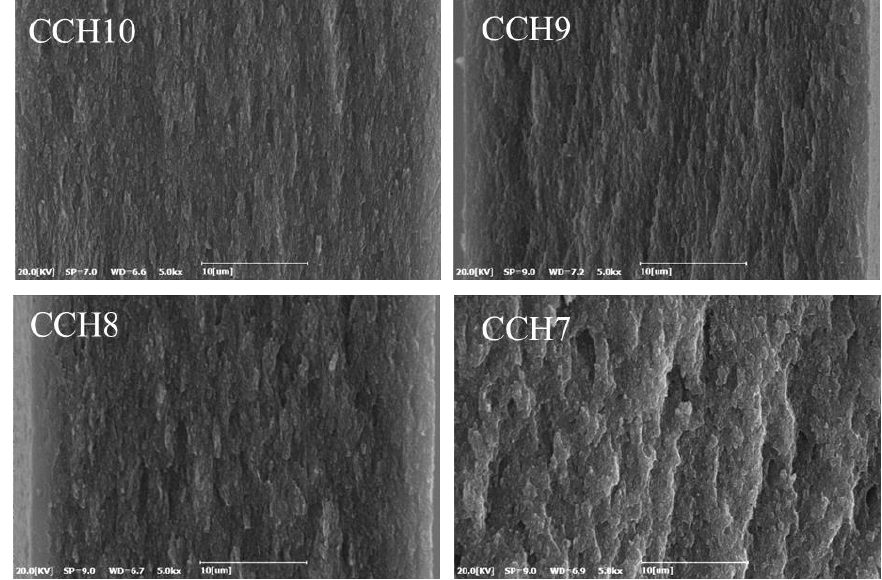
Figure 2. SEM images of the cross section of the CCH films (×5000).